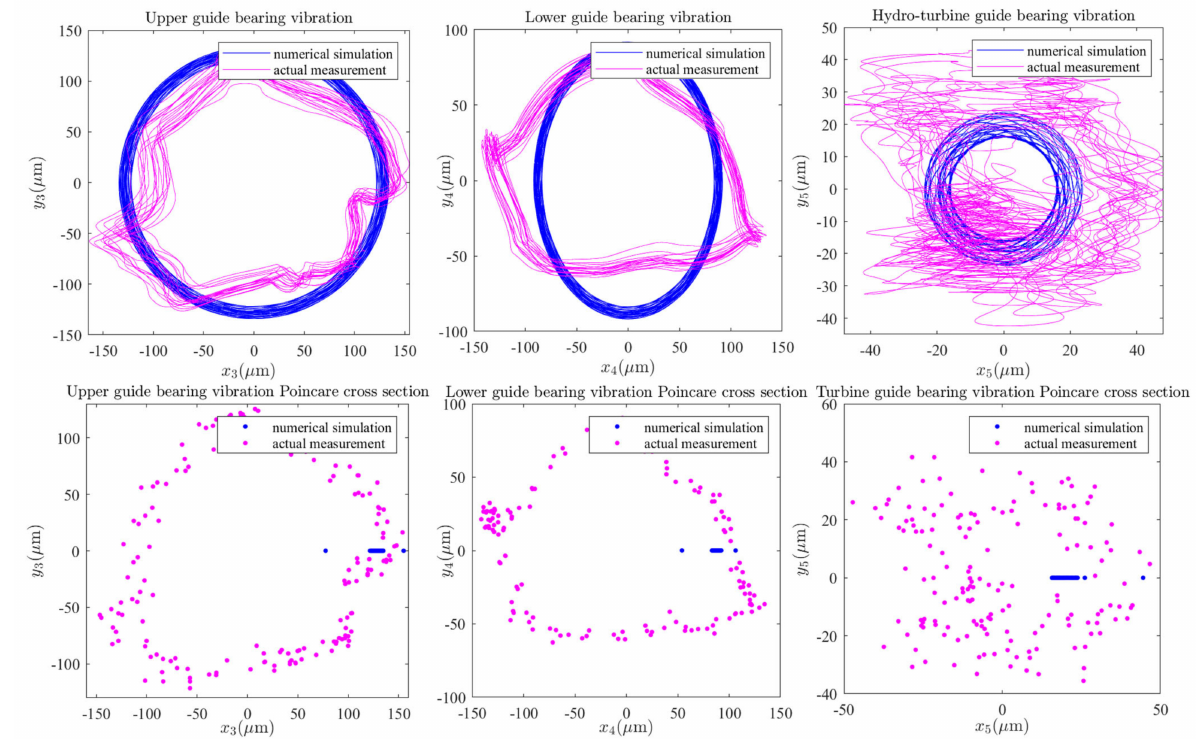
Figure 22. Guide bearing vibration axial center trajectories and Poincare